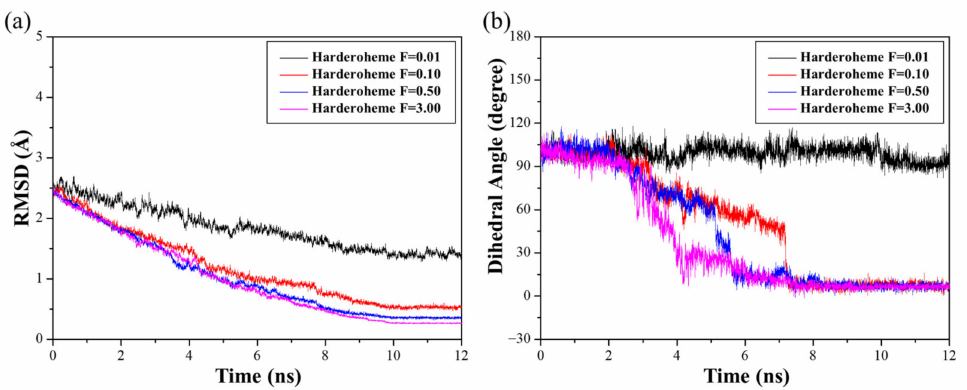
Figure 5. Time-dependent results from four individual targeted molecular dynamics (TMD) simu- lations of the harderoheme clockwise rotation process using different harmonic force constants of 0.01, 0.10, 0.50 and 3.00 kcal/(mol · Å 2 ), respectively. ( a ) RMSD values of all backbone atoms. ( b ) The evolution of the dihedral angle of C α (sub-p4) -Fe (sub) -N δ (His171) -O η (Tyr145)